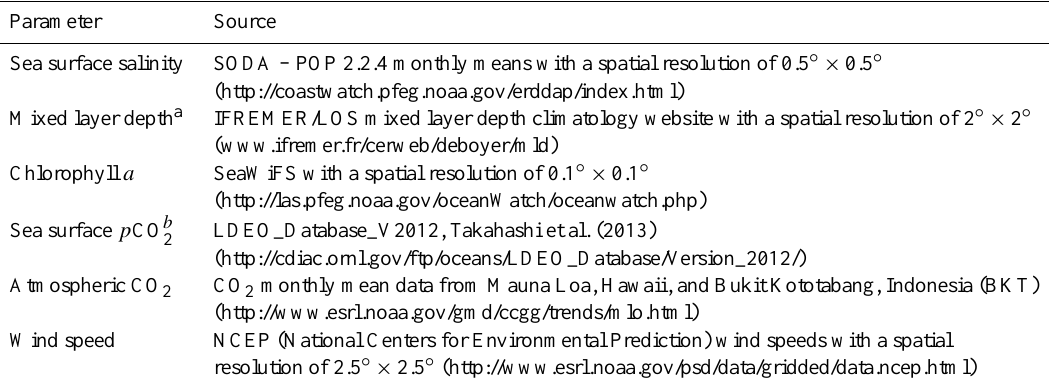
Table 2. Sources of data used in this